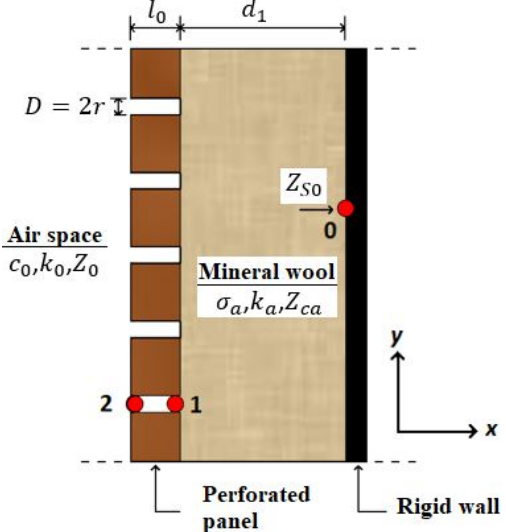
Figure 2. Configuration of an example perforated system.